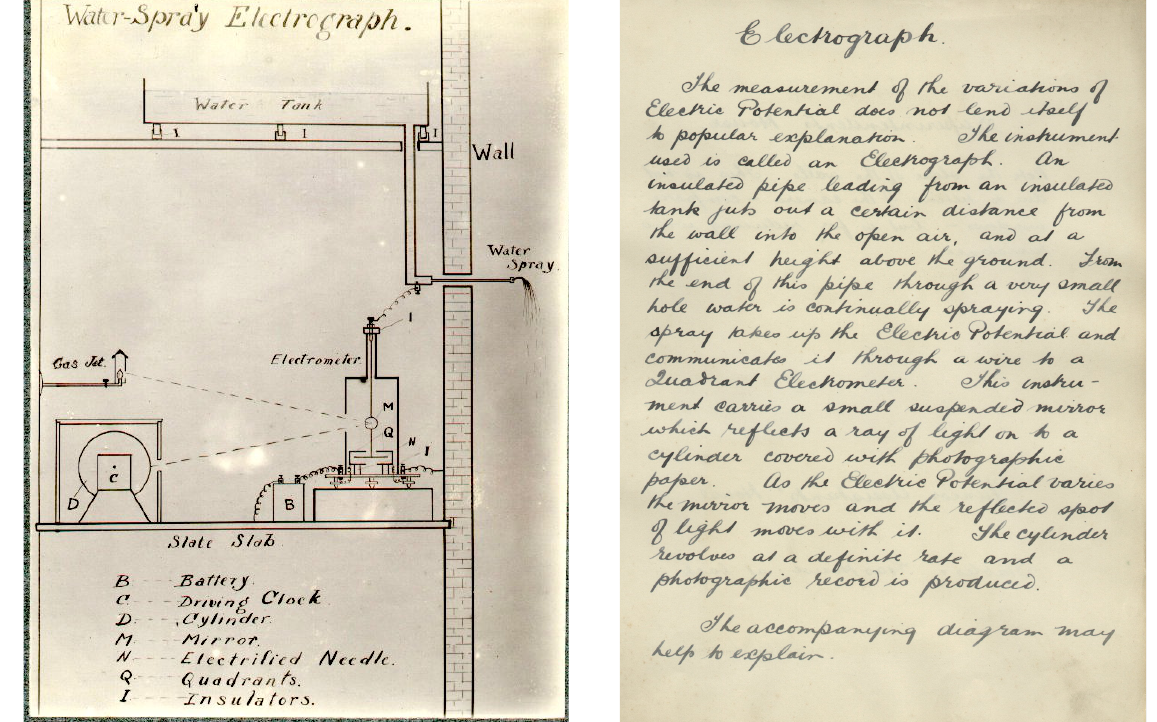
Figure 2 Description (right) and diagram (left) of the water-dropper apparatus, showing photographic recording. Taken from Gendle (1912). Figure 2. Description (right) and diagram (left) of the water dropper apparatus, showing photographic recording. Taken from Gendle